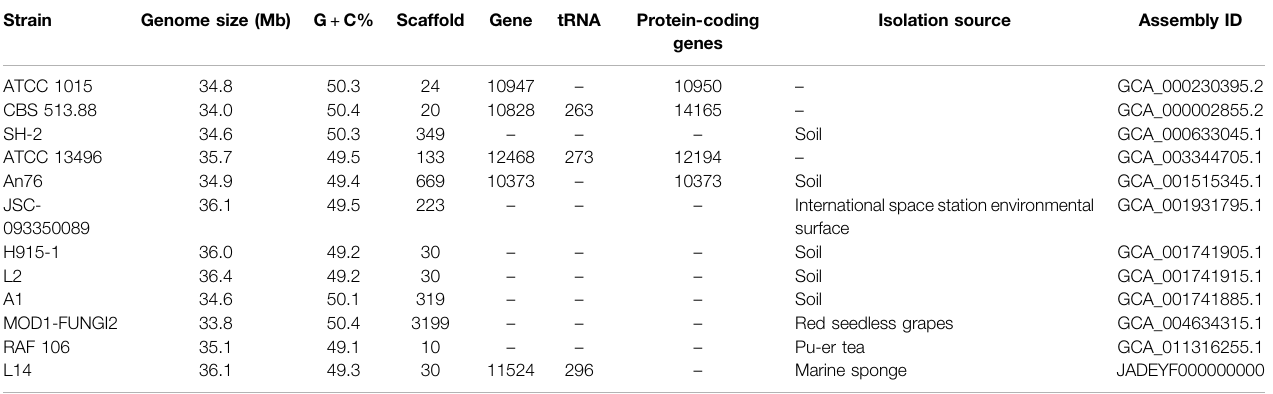
TABLE 1 | General genomic features of 12 Aspergillus niger strains from NCBI database. Strain Genome size (Mb) G + C% Scaffold Gene tRNA